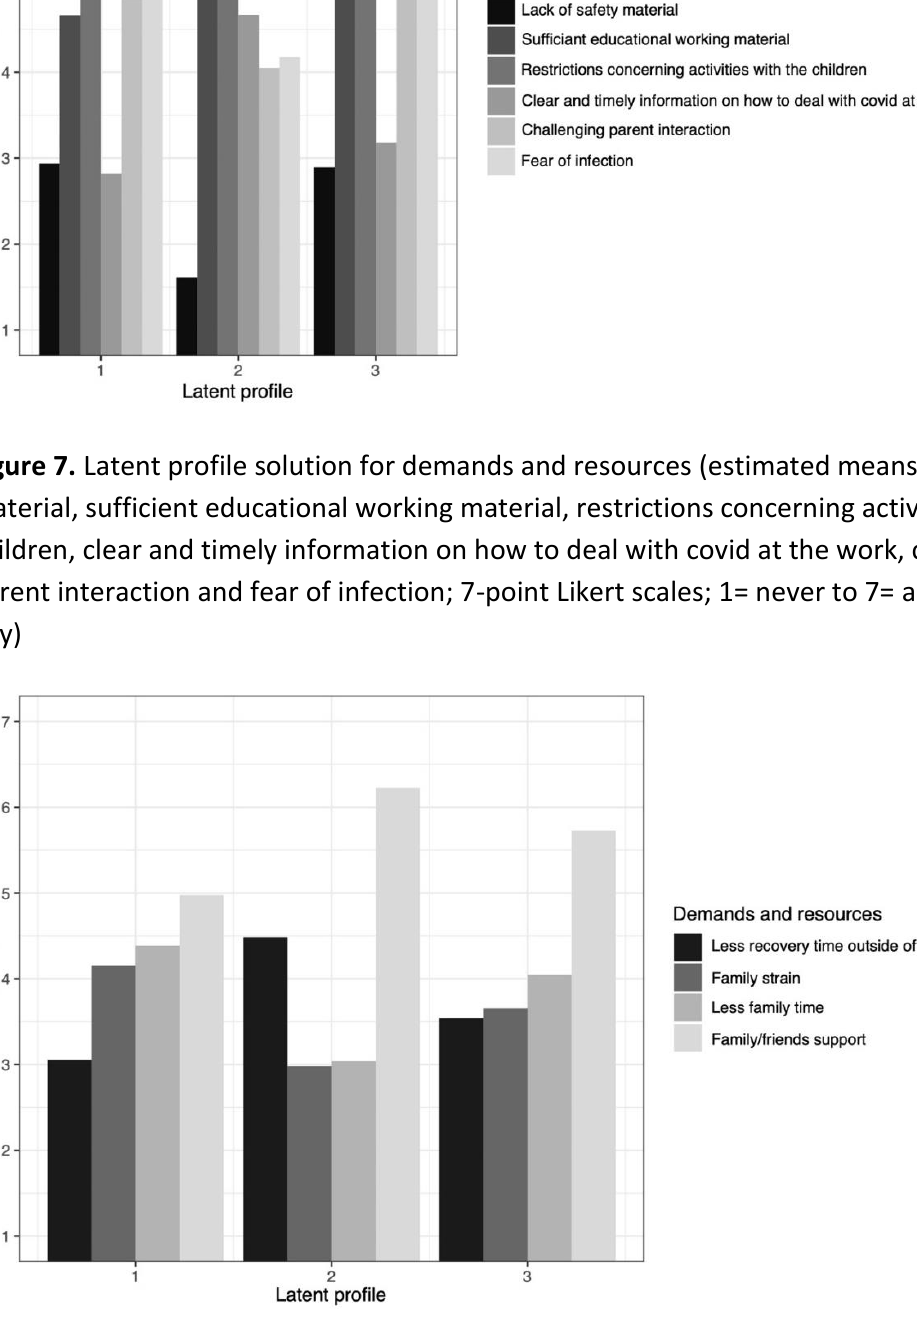
Figure 8. Latent profile solution for demands and resources (estimated means: less recovery time outside of work, family strain, less family time, family/friends